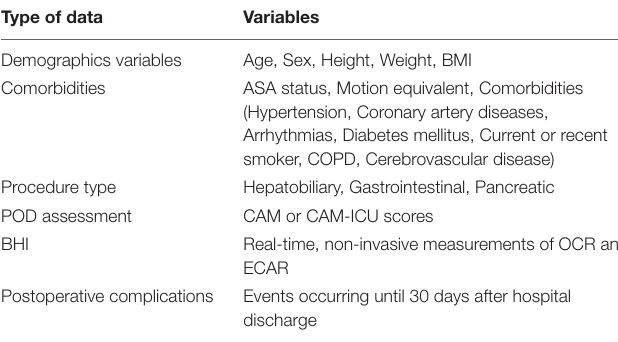
TABLE 1 | Data collected in the